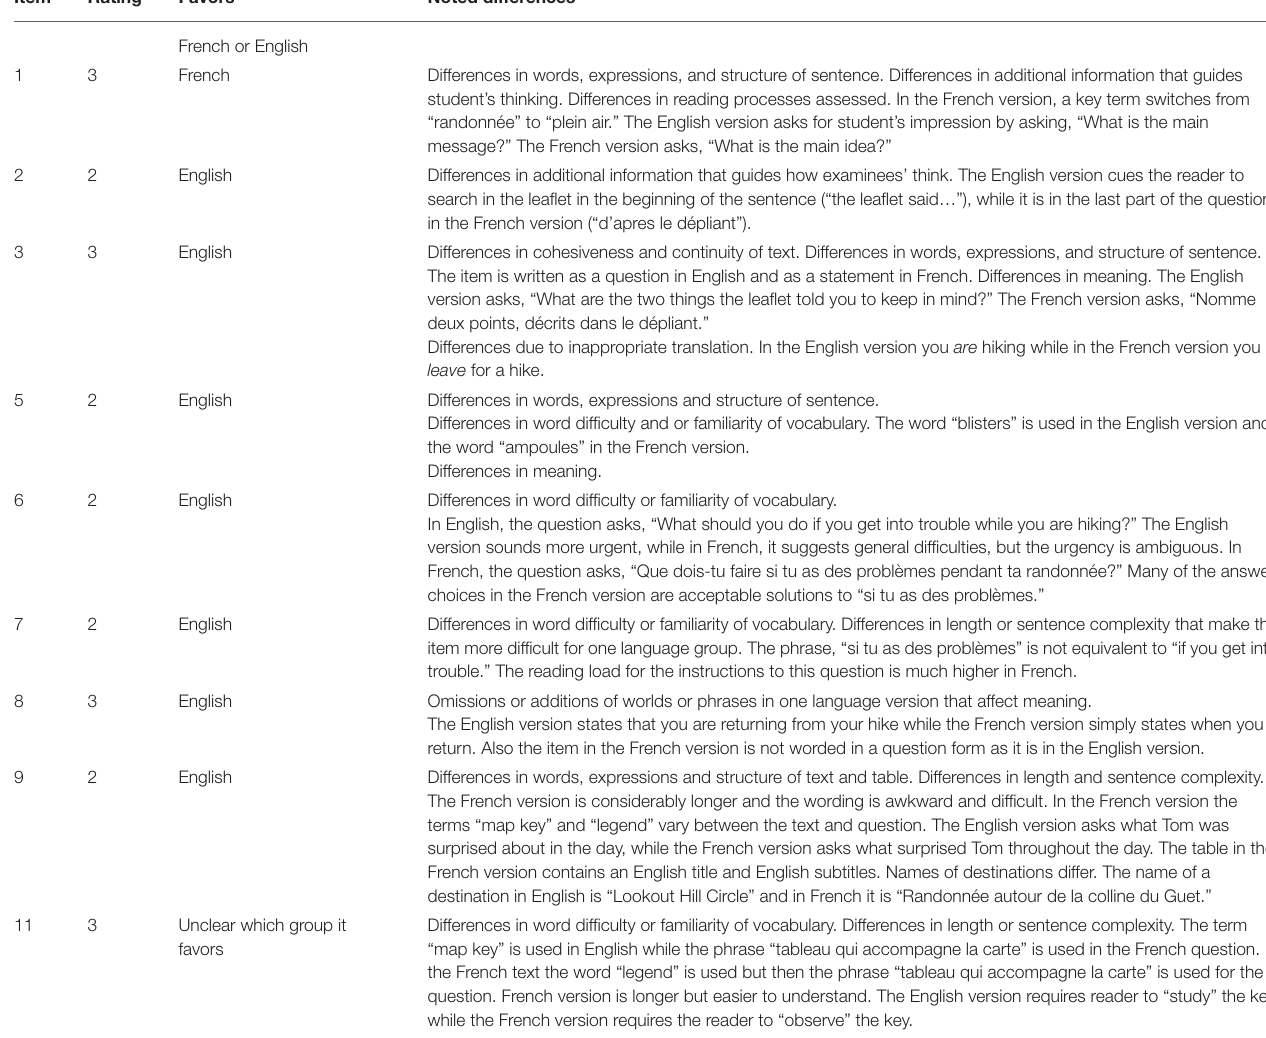
TABLE 6 | Passage 2 “Day Hiking” expert review ratings and noted